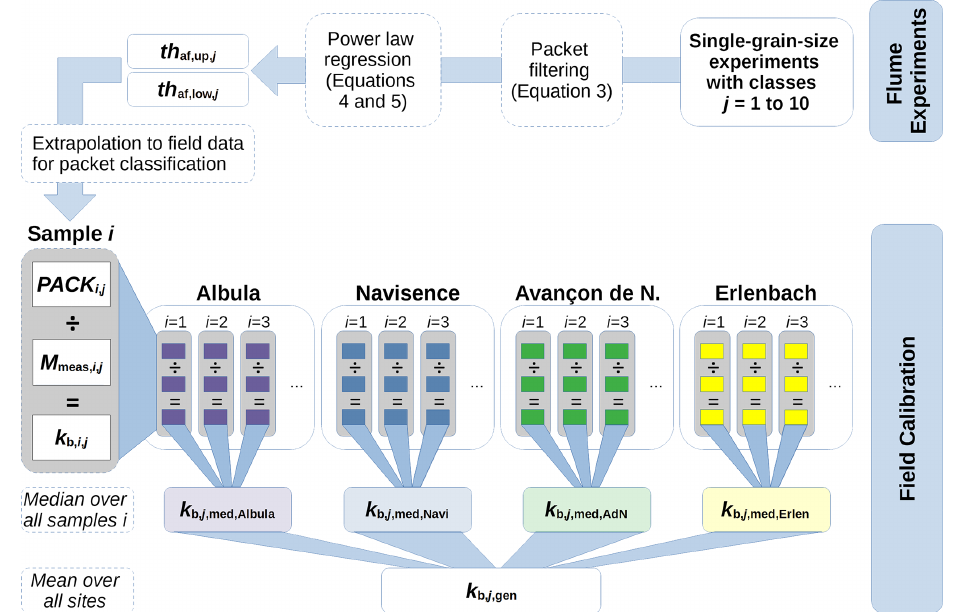
Figure 6. Workflow leading from the single-grain-size flume experiments with particles from 10 size classes j (top right) to the final array of general calibration coefficients k b ,j, gen . Central elements are the lower and upper threshold values th af , low ,j and th af , up ,j , the number of recorded packets PACK i,j per sample i and class j , the sampled fractional mass M meas ,i,j , the sample- and class-specific calibration coefficient k b ,i,j , and finally the site-specific median calibration coefficient k b ,j, med , station . To enable a comparison with the AH method developed by Wyss et al. (2016a), the “field calibration” part of the workflow was also carried out with the AH thresholds th ah ,j (see Table